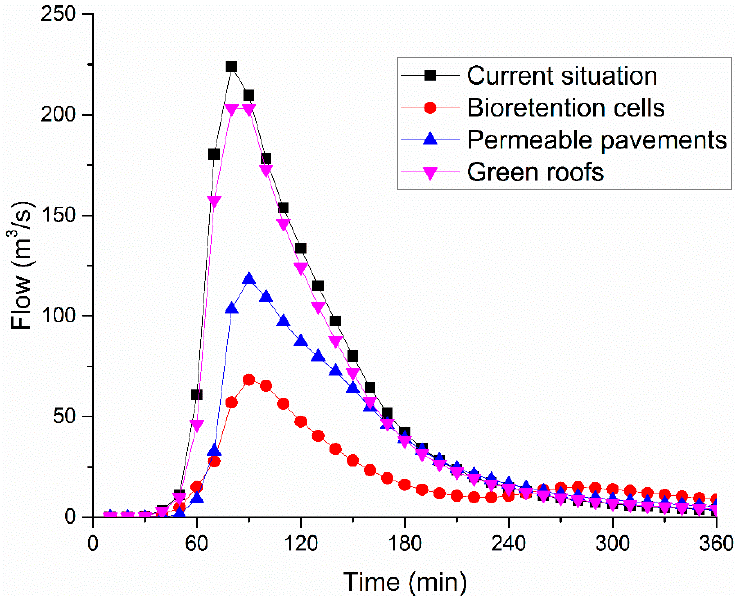
Figure 8. Outlet flow process under P = 5 rainfall.